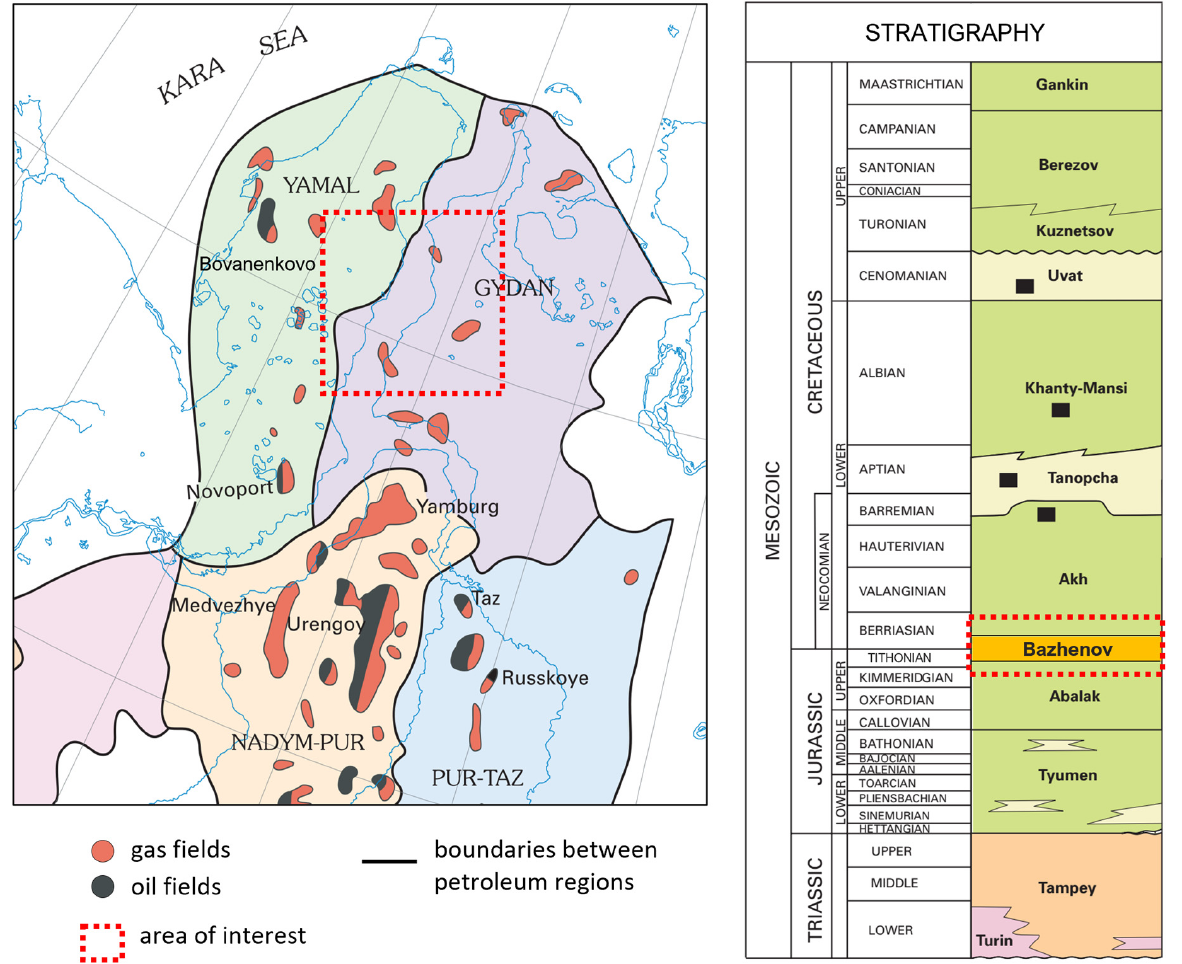
Figure 1. Research area ( left ) and stratigraphic column of the region ( right ). Figures modified after Ulmishek [29].